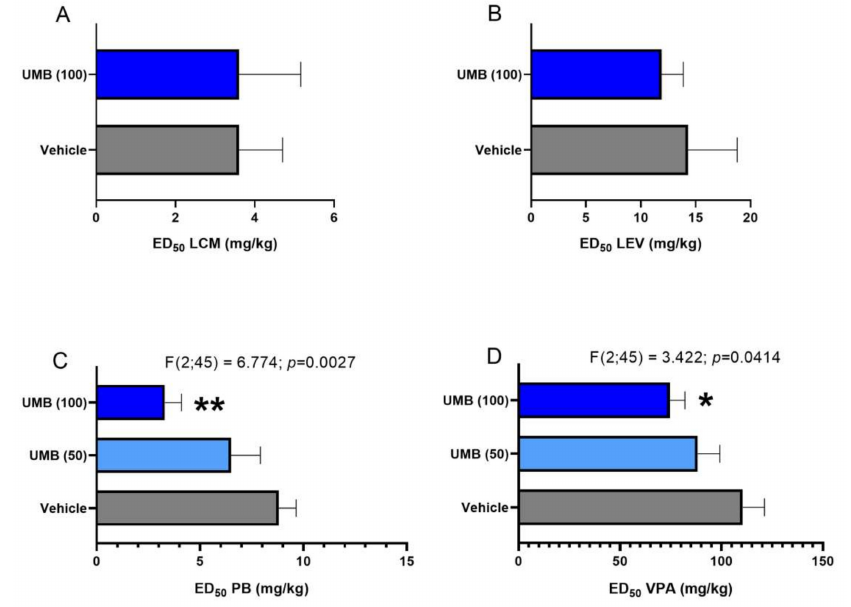
Figure 1. ( A – D ) Effects of UMB on the anticonvulsant potency of CBZ, LCM, LTG and VPA in the 6 Hzcorneal-stimulation-induced seizure model in mice. Columns represent median effective doses (ED 50 in mg/kg ± SEM) of antiepileptic drugs (LCM ( A ), LEV ( B ), PB ( C ) and VPA ( D )) that protected half of the tested mice from psychomotor seizures. The log-probit method was used for calculating the ED 50 values (each experimental group consisted of 8 mice). ** p < 0.01, * p < 0.05 vs. control (PB, VPA + vehicle-treated) animals (one-way ANOVA and post-hoc Tukey–Kramer